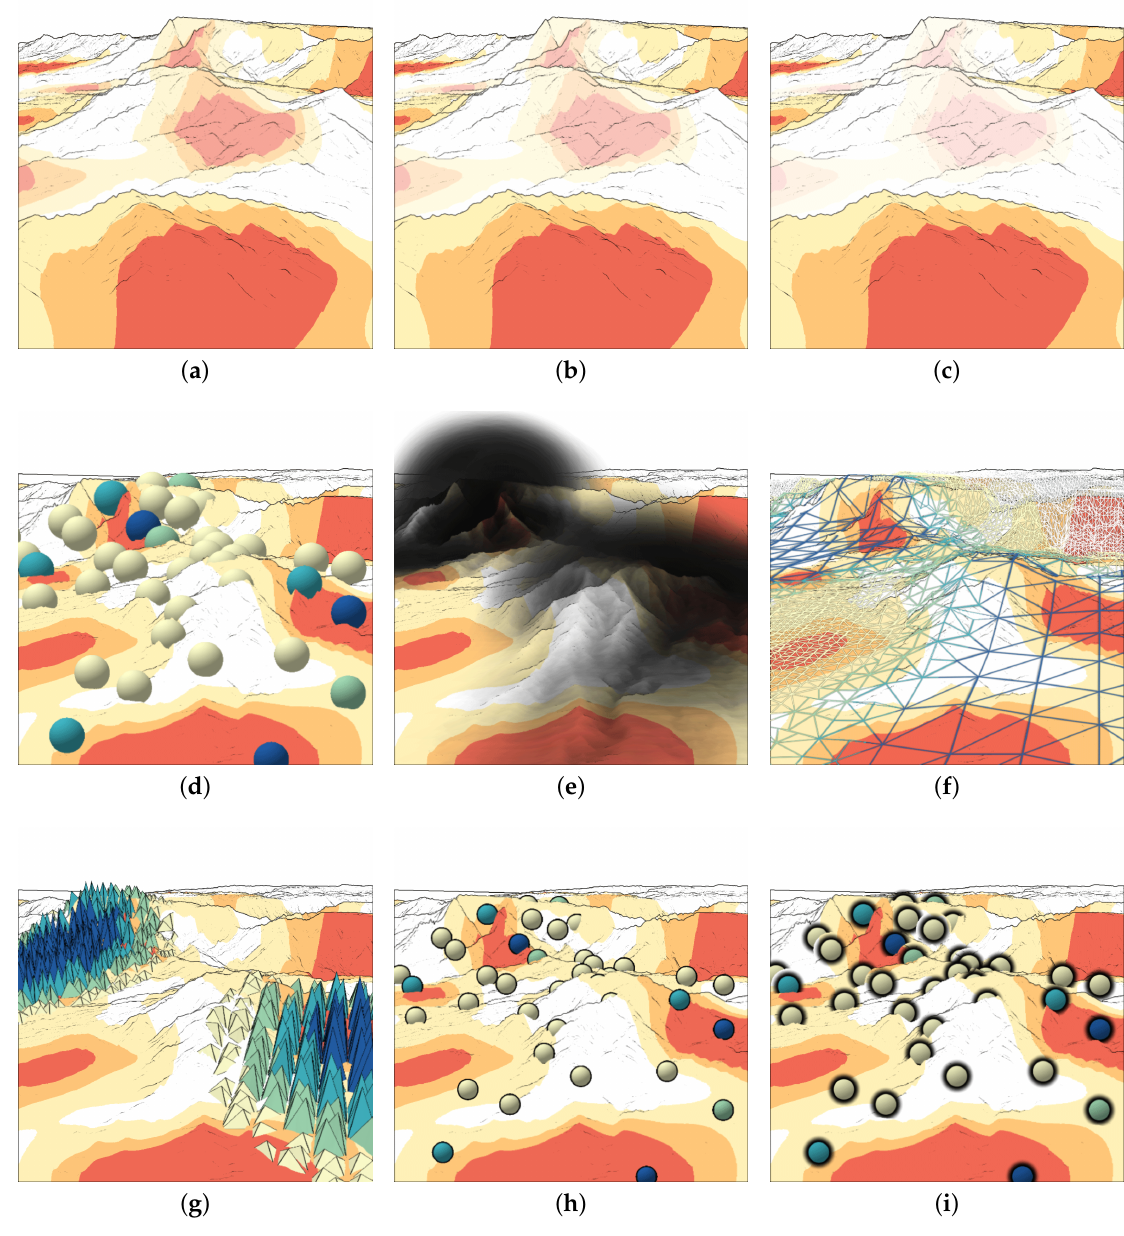
Figure 9. Options for visualizing uncertainty. ( a ) 45% transparency; ( b ) 65% transparency; ( c ) 85% transparency; ( d ) circular glyphs; ( e ) fog; ( f ) grid overlay; ( g ) tetrahedral glyphs with redundant encoding by height and color; ( h ) outline stylization; ( i ) halo